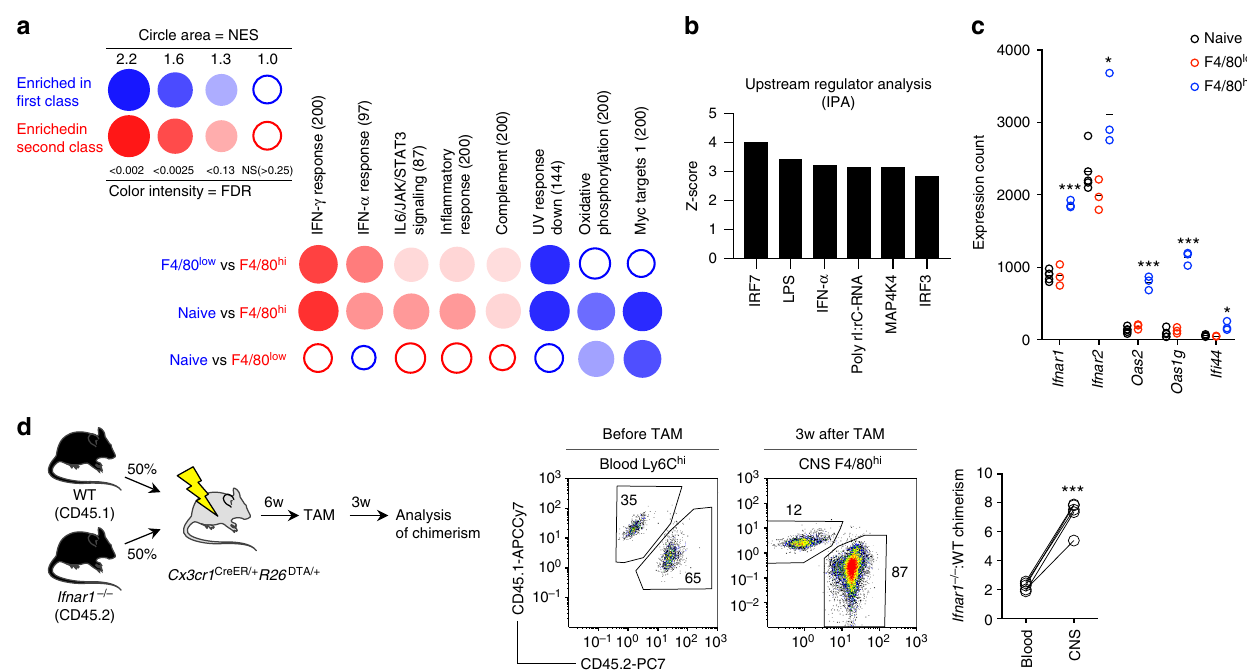
Fig. 7 Type I IFNs regulate niche colonization. a Analysis of enrichment of hallmark gene sets visualized using BubbleGum. Color indicates the cell subset showing enrichment, and the size and color of circles represent enrichment score and signi fi cance, respectively. b Top activated upstream regulators using ingenuity pathway analysis. c Microarray expression counts of type I IFN receptors and response genes. Lines represent mean values. * p < 0.05, *** p < 0.001 by Student ’ s unpaired two-tailed t -test comparing F4/80 low and F4/80 hi . d Analysis of chimerism in WT: Ifnar1 – / – competitive chimeras before TAM administration (blood) or 3 weeks after TAM (CNS). Blood is gated on CD11b + SSC low Ly6C hi monocytes and CNS on CD11b + F4/80 hi . n = 4 mice. The experiment was performed once. *** p < 0.001 by Student ’ s paired two-tailed t